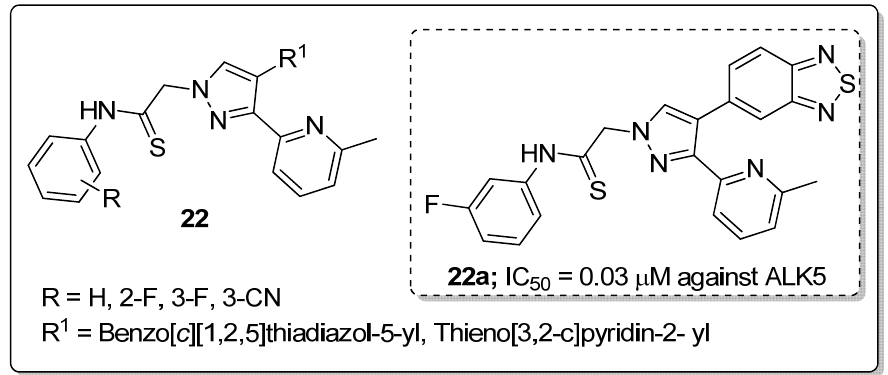
Figure 26. ALK5 kinase inhibitory activity of the most active pyridine-pyrazole derivative 22a .